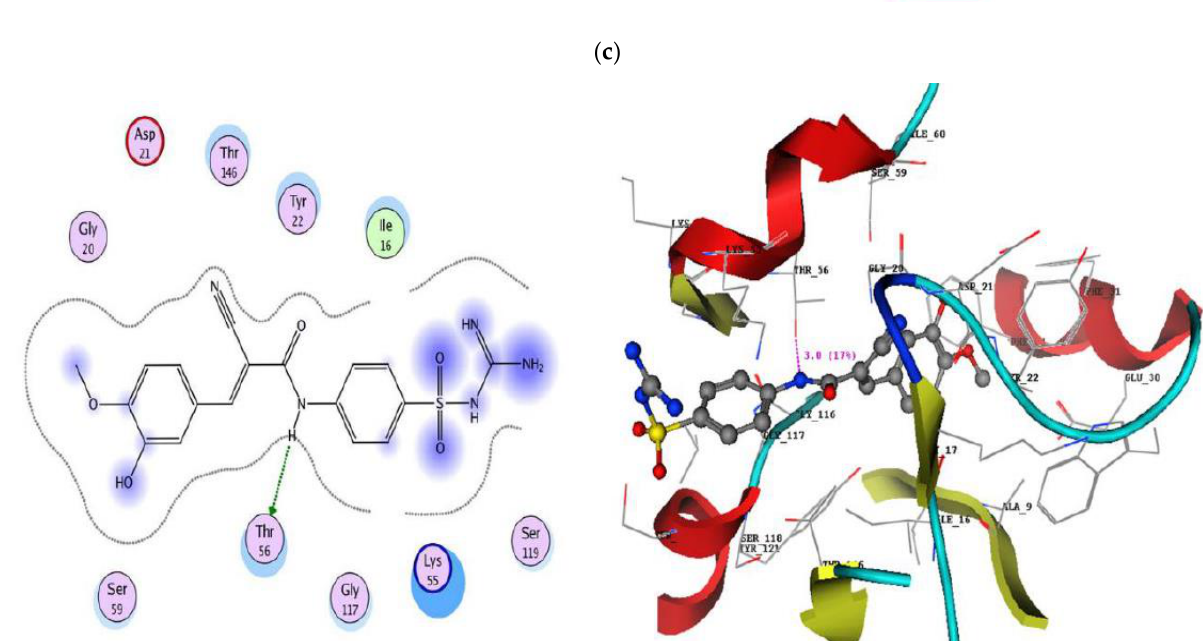
( e ) Figure 3. ( a ) 2D and 3D structure of compound 2d inside the active site DNA gyrase (2XCT). ( b ) 2D and 3D structure of compound 3a inside the active site DNA gyrase (2XCT). ( c ) 2D and 3D structure of compound 2a inside the active site DHFR (1DLS). ( d ) 2D and 3D structure of compound 2d inside the active site DHFR (1DLS). ( e ) 2D and 3D structure of compound 3a inside the active site DHFR (1DLS). 3. Materials and Methods 3.1. Chemistry Uncorrected melting points (MPs) of all the newly designed compounds were deter- mined and recorded on a digital Gallen Kamp MFB-595 instrument using open capillaries and the recorded MPs were reported as such. A SHIMAZDU IR AFFINITY-I FTIR spec- trophotometer was used for recording the IR spectra within the range of 400–4000 cm −1 . A Bruker 400 MHz spectrometer was used to assessment of the 1 H and 13 C signals in the